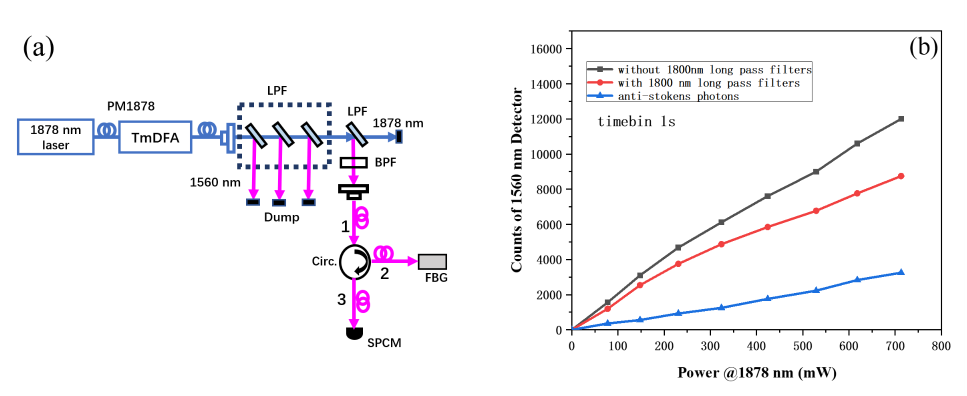
Figure 9. ( a ) The experimental device diagram. ( b ) The data of noise photons from TmDFA with or without 1800 long-pass filter. (T ∼ 1.27%@1560 nm, T ∼ 91.98%@1878